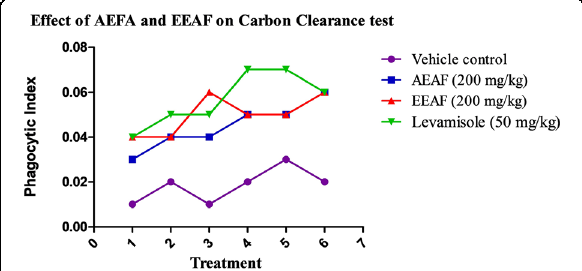
Fig. 12 Effect of AEAF and EEAF on Carbon Clearance test in mice. Results were expressed as mean ± SEM, ( n = 6). Statistical analysis was performed with one-way analysis of variance (ANOVA) followed by Dunnett ’ s multiple comparison test